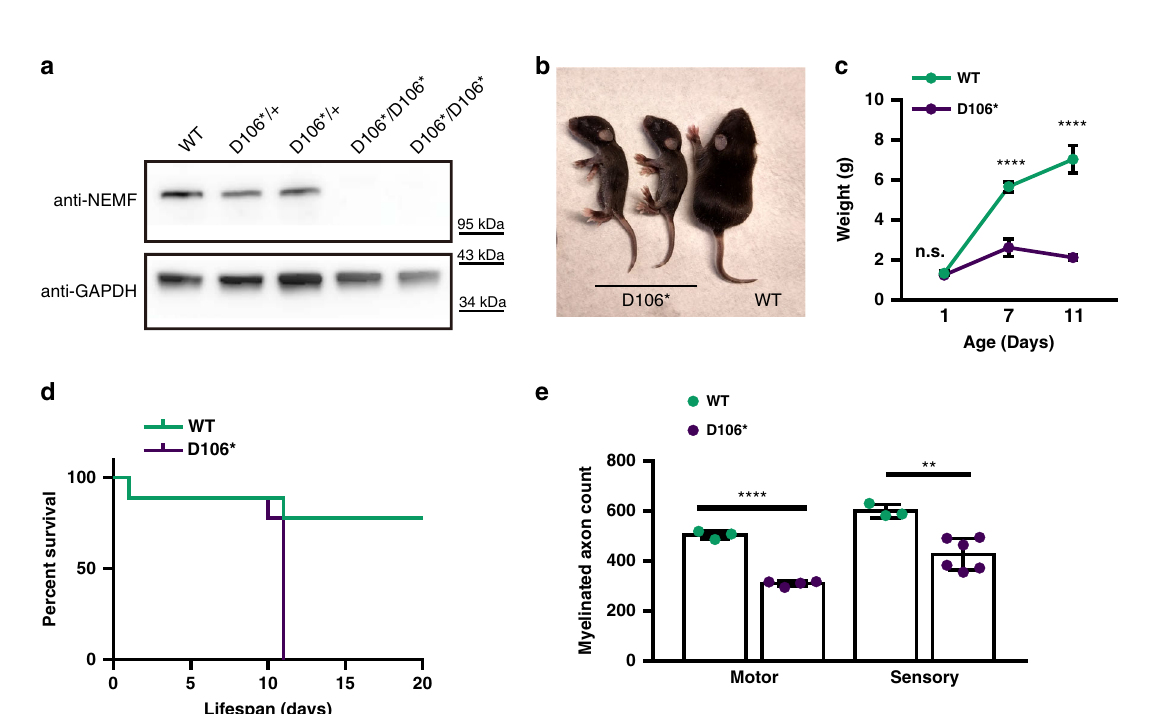
Fig. 2 Nemf ENU mutations cause progressive neuromuscular degeneration. a – e Representative images of neuromuscular junction (NMJ) staining of medial gastrocnemius (MG) muscle from mice of indicated genotypes and ages. Tissues were stained for presynaptic vesicles (anti-SV2, green), neuro fi laments (anti-neuro fi lament 2H3, green), and acetylcholine receptor ( α -bungarotoxin, red). Unoccupied (arrow) and partially occupied (arrowhead) junctions are highlighted. Scale bar, 60 µ m. Inset scale bar, 30 µ m. f Quanti fi cation of fully innervated, partially innervated or denervated NMJs based on presynaptic and postsynaptic staining overlap. Eight-week-old WT, R487G and R86S mice ( n = 4, 5, and 3 respectively), and 55-week-old WT and R487G mice ( n = 4 and 3, respectively) were analyzed. By 8 weeks R487G or R86S mice compared to WT (**** p < 0.0001), but were not different from one another ( p = 0.4391). Fifty- fi ve weeks of age, R487G vs. WT (**** p < 0.0001). Data are presented as mean percent occupancy value ± SD. Statistical analysis was performed by two-way ANOVA followed by Tukey ’ s multiple comparison, for % fully occupied. g – n Representative cross-sections of femoral nerve motor branches from mice of indicated genotypes and ages. Scale bar, 20 µ m. o Total myelinated axon number in cross-section of WT and Nemf mutant mice at 8-week-old wild-type (WT), R487G and R86S mice ( n = 9, 7, and 4, respectively), and 55-week-old WT and R487G mice ( n = 6 and 4, respectively). Eight weeks (WT vs. R487G **** p < 0.0001, WT vs. R86S **** p < 0.0001 and R487G vs. R86S *** p = 0.0005). Fifty- fi ve weeks (WT vs. R487G **** p < 0.0001. R487G 8 weeks vs. 55 weeks n.s. p = 0.9767). p Myelinated axon number in cross-sections of L4 ventral roots of WT and Nemf ENU mice. Analysis of 8-week-old WT, R487G and R86S mice ( n = 5, 3, and 4, respectively), and 55-week-old WT and R487G mice ( n = 4 each). At 8 weeks of age R487G vs. WT * p = 0.0136, R86S vs. WT **** p < 0.0001, R487G vs. R86S ** p = 0.0063, by 55 weeks of age R487G vs. WT **** p < 0.0001, R487G 8 weeks vs. R487G 55 weeks ** p = 0.0055. o , p Individual data points and mean ± SD are indicated. Statistical analysis was performed by one-way ANOVA followed by Tukey ’ s multiple comparison (wild-type, orange squares; R487G, purple circles; R86S, green triangles). Source data for f , o , p are provided as a source data fi le.